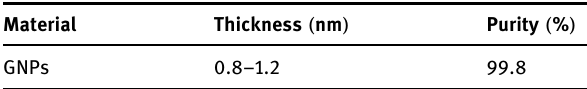
Table 2: Material characteristics of